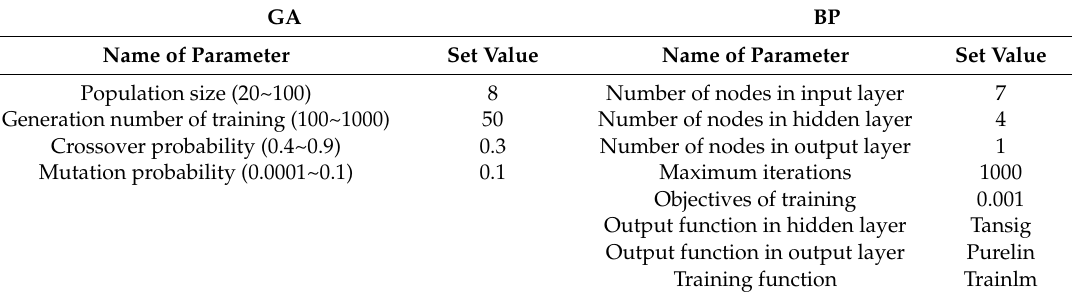
Table 2. The basic parameters of the model Settings.